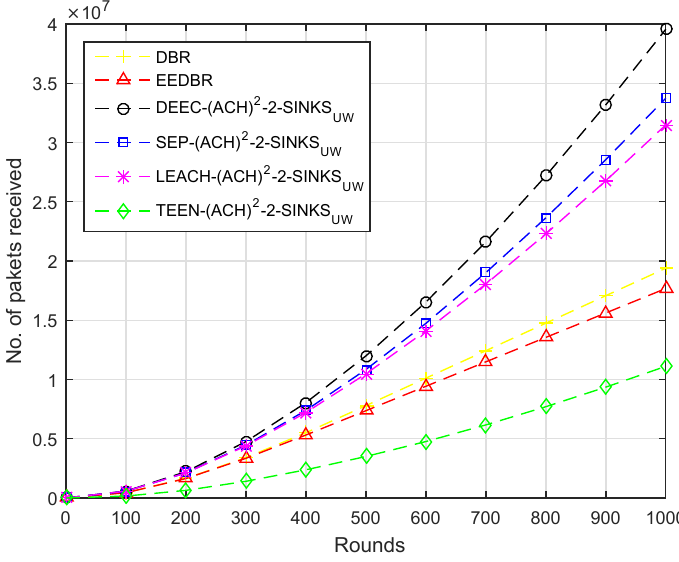
Figure 17. Number of Packets Received at